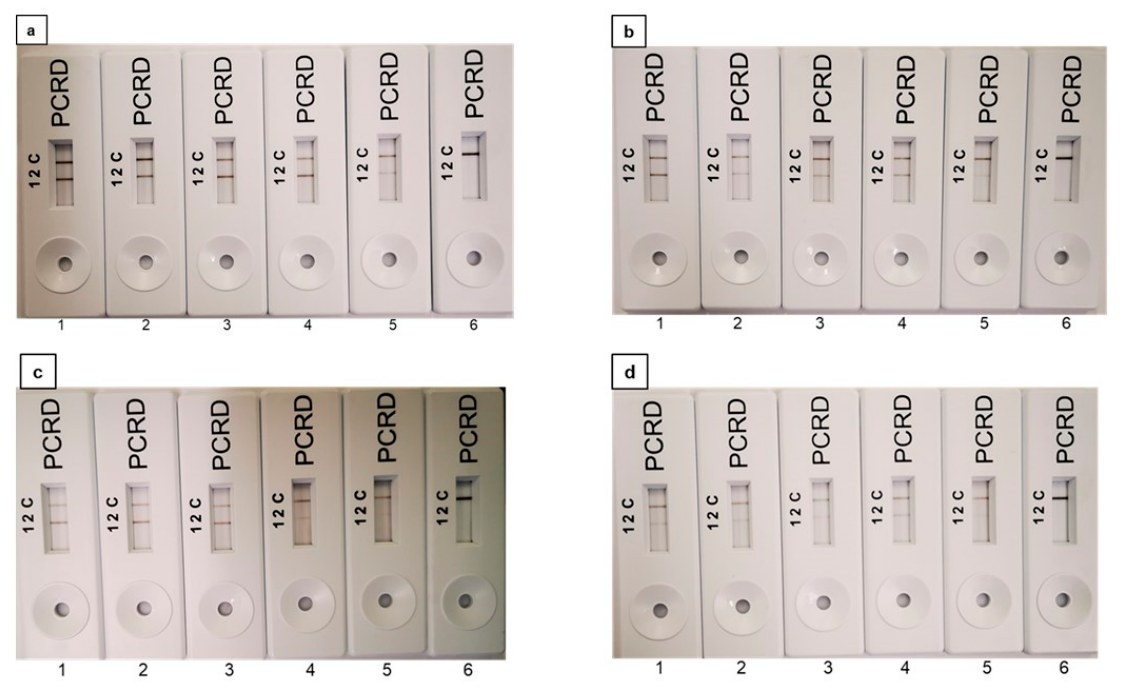
Figure 5. PMAxx-recombinase polymerase assay-lateral flow assay (RPA-LFA) for the detection of VBNC E. coli O157:H7 from ( a ) pure culture; ( b ) milk; ( c ) drinking water; ( d ) apple juice. LFA 1 to 6: 9-fold serially diluted VBNC E. coli O157:H7 cells with counts ranging from 1.3 × 10 6 CFU mL − 1 to 1.3 × 10 2 CFU mL − 1 , respectively. LFA 6: NTC.